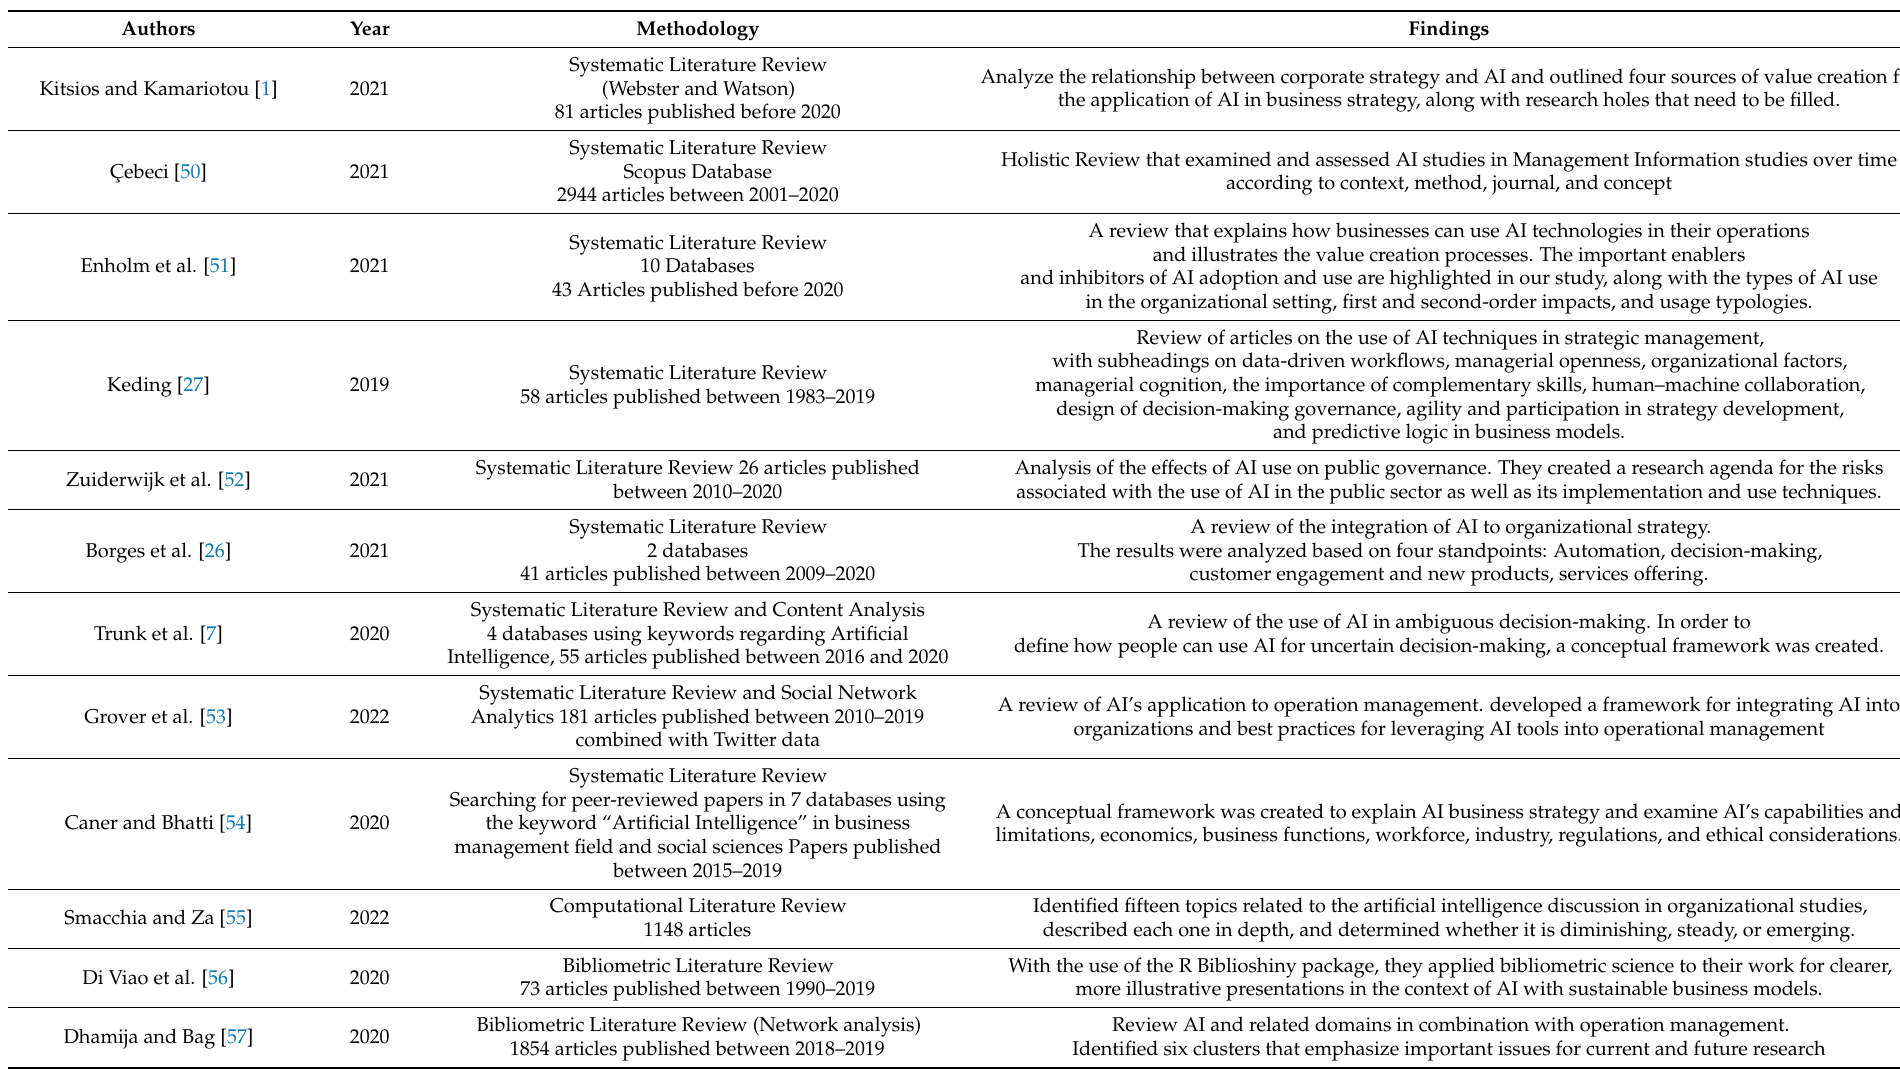
Table 1. Prior Literature Reviews. Source: Own